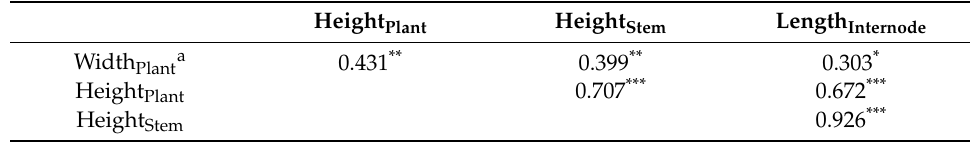
Table 3. Pearson linear correlations between plant size-related traits ( n = 44).